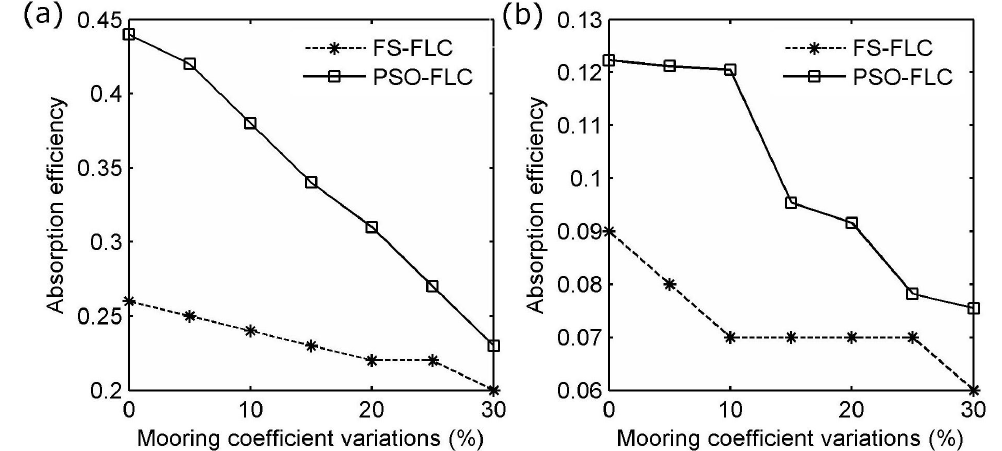
Figure 11. Controller sensitivity to variations in the mooring stiffness coefficient under a sea-state of H = 1.25 m ( a ) T = 11 s; ( b ) T = 7 s p p